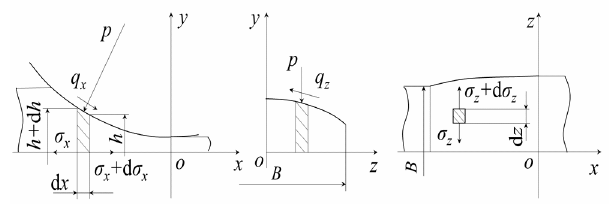
Figure 7. Stress state of the segment of the strip in the deformation zone.